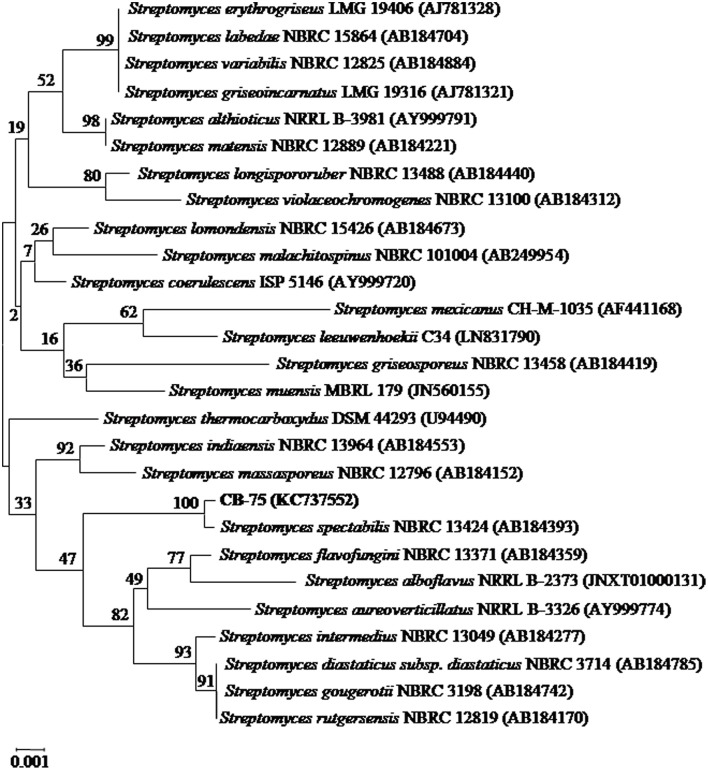
Neighbor-joining phylogenetic tree based on almost complete 16S rRNA gene sequences (1,490 nucleotides) showing the phylogenetic relationship between strain Streptomyces sp. CB-75 and representatives of some other related taxa. Bootstrap percentages based on 1,000 resamplings are listed at nodes, only values above 50% are shown. GenBank accession numbers are given in parentheses. Bar, 0.001 substitutions per nucleotide position.